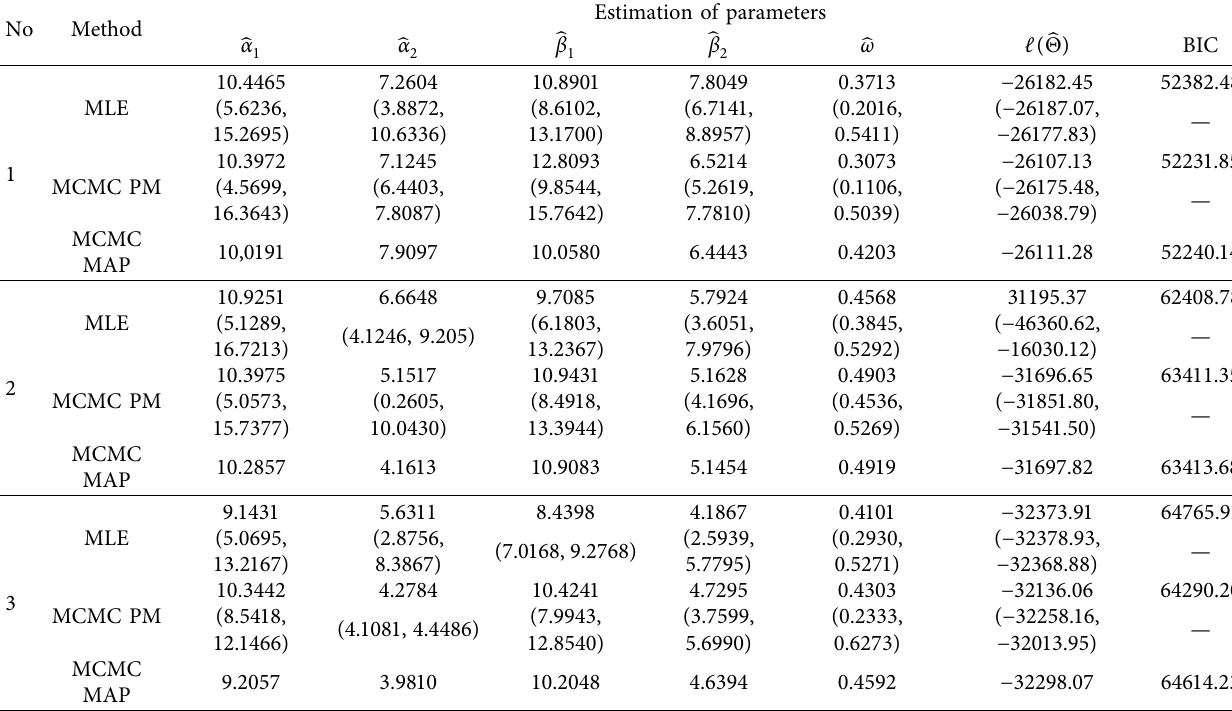
Table 2: The results of the proposed methods for the parameters using the mixed distribution. Estimation of No Method